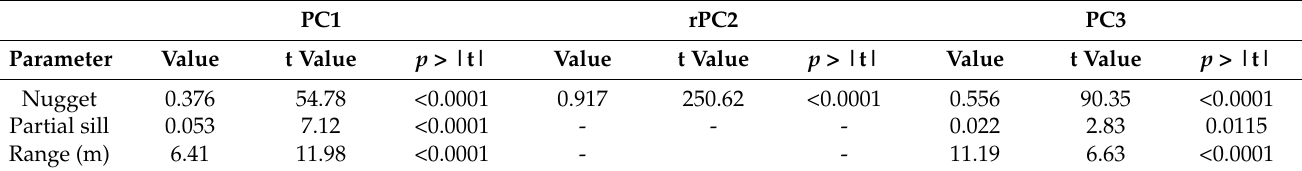
Table 5. LSE estimates of the variogram parameters for PC1, rPC2, and PC3.